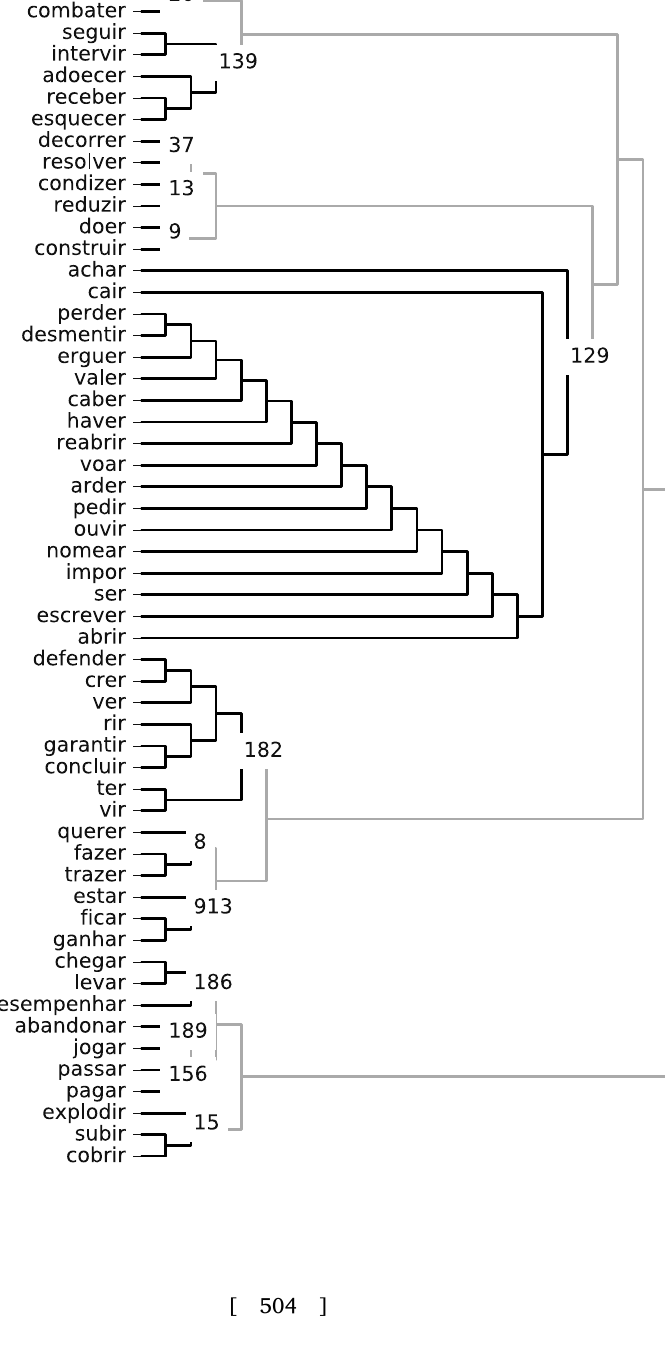
Figure 4: History of merges for European Portuguese macroclasses, on and global